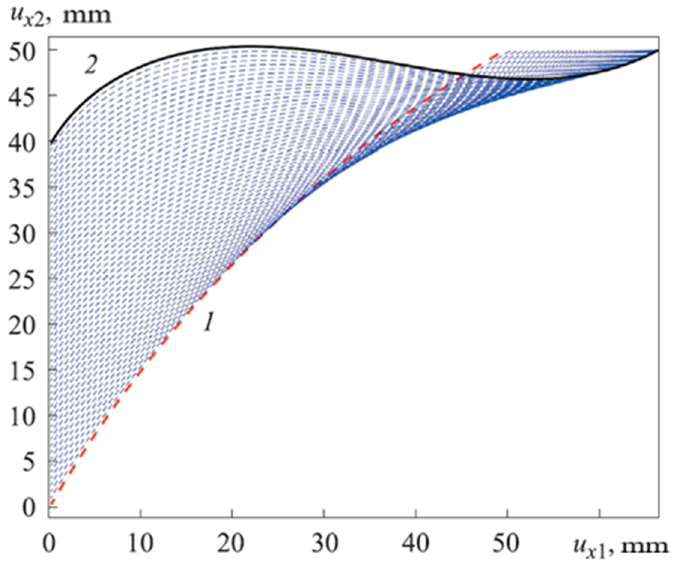
Figure 8. Graphs of the rod deformation axis: 1 is the initial shape of the rod axis; 2 is the shape of the rod axis at the last loading step.